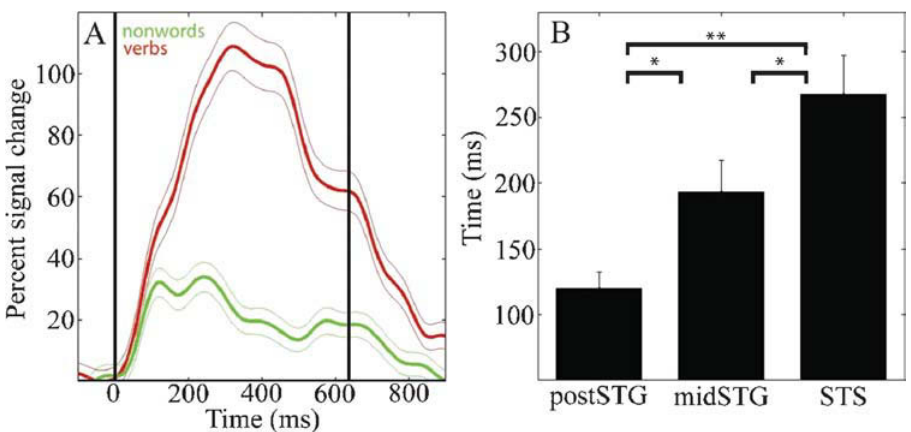
Figure 2. ( A ) Mean ( ± SE) percent signal change of HG analytic amplitude for verbs (red) and nonwords (green) for an electrode over the STS in patient A (49, see Figure 4A for location). Black vertical lines indicate onset and offset of verb stimulus. ( B ) Processing of words as opposed to acoustically matched nonwords sequentially activates the post-STG, then the mid-STG, followed by the STS. Mean ( ± SE) onset time of significantly different HG activity for words versus